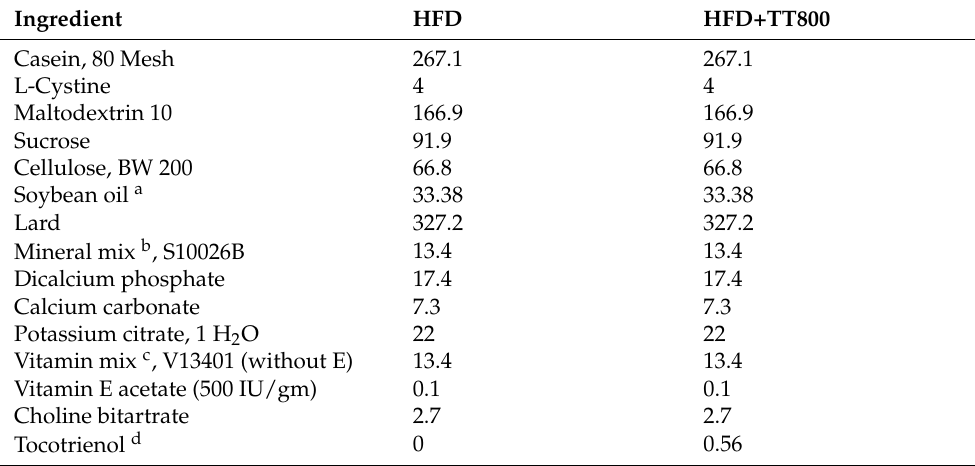
Table 1. Ingredient composition of the experimental diets